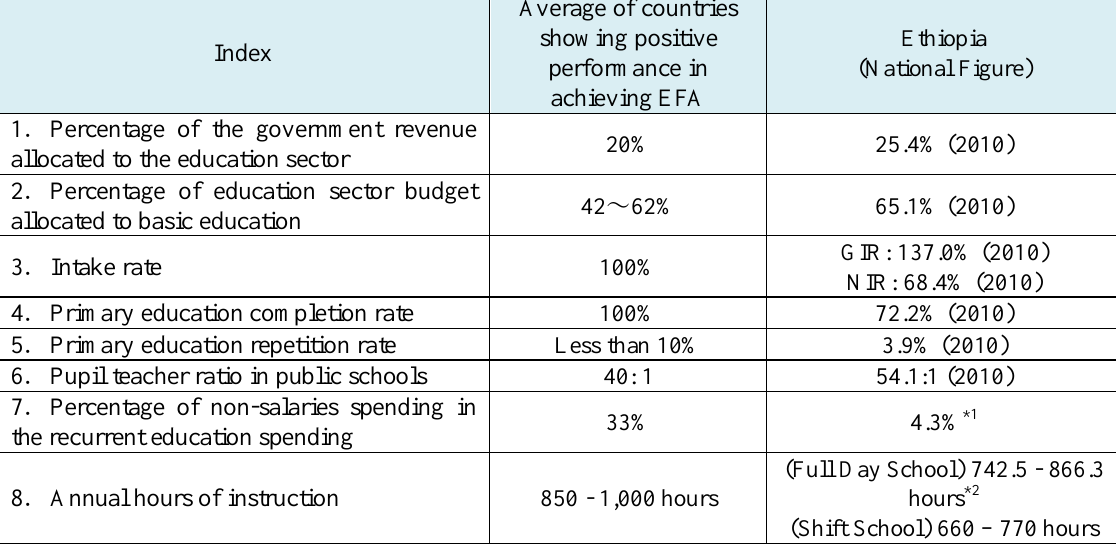
Table 7-2: Comparison of EFA-FTI Indicative Framework Indices Index